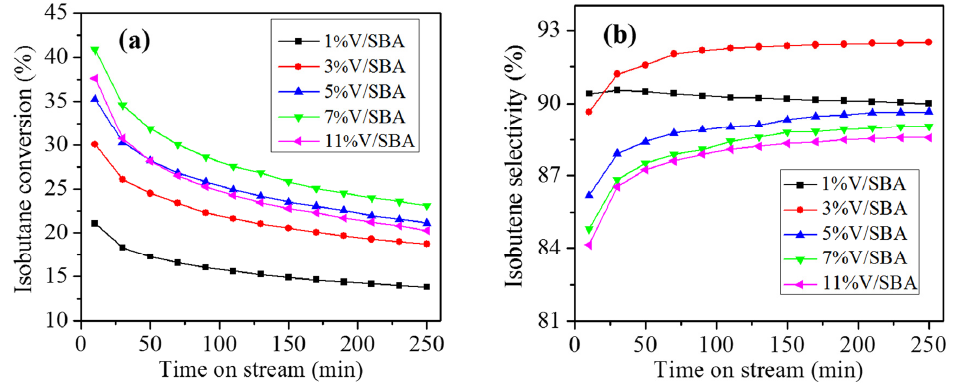
Figure 8. Conversion of isobutane ( a ) and selectivity to isobutene ( b ) as a function of time on stream for V/SBA catalysts at 570 °C. Table 2. Reaction data of SBA ‐ 15 ‐ supported vanadia catalysts a .